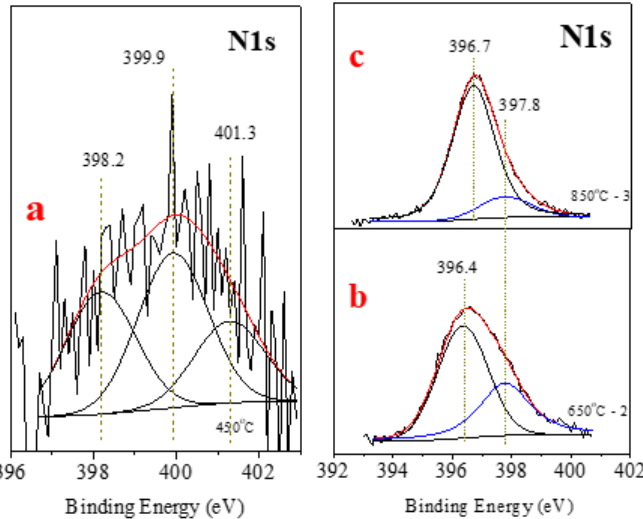
Figure 10. ( a – c ). XPS spectra of the N1s core level for the annealed